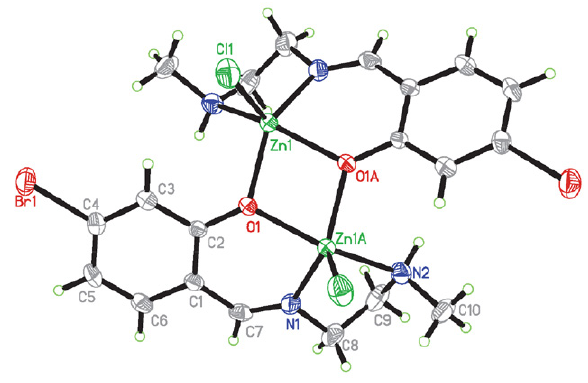
Fig. 1. Molecular structure of complex 1 . Atoms labeled with the suffix A are related to the symmetry operation 1 – x , 1 – y , z .